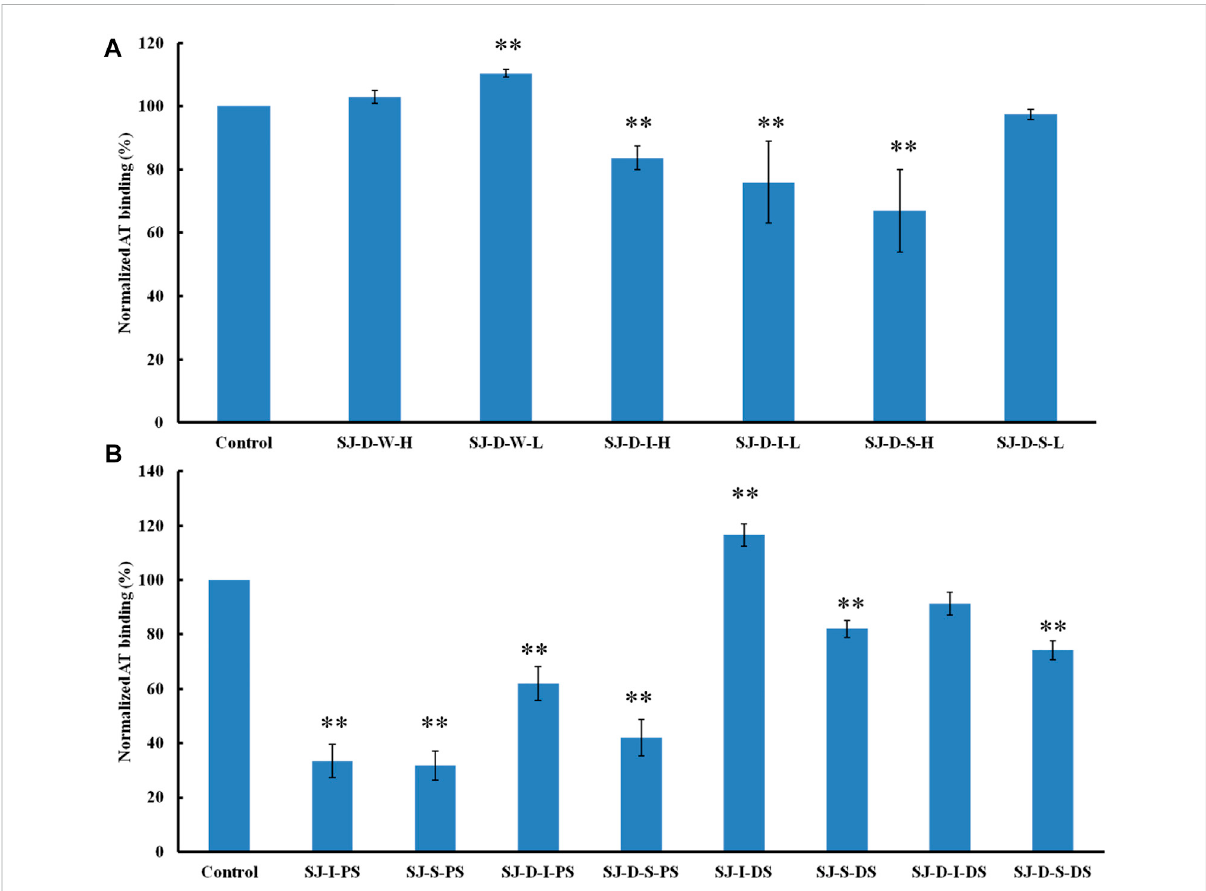
FIGURE 4 The binding abilities to AT (250 nM) premixed with different chemical modi fi ed polysaccharides (1 µM) on a heparin chip. (A) Polysaccharides obtained from autohydrolysis and (B) desulfated or oversulfated polysaccharides. All bar graphs with standard deviations were based on triplicate experiments. * p < 0.05, ** p < 0.01 compared with